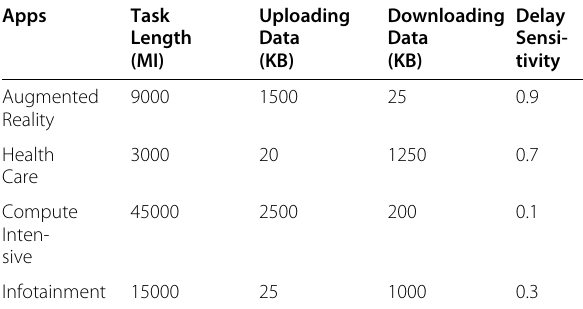
Table 4 Application characteristics